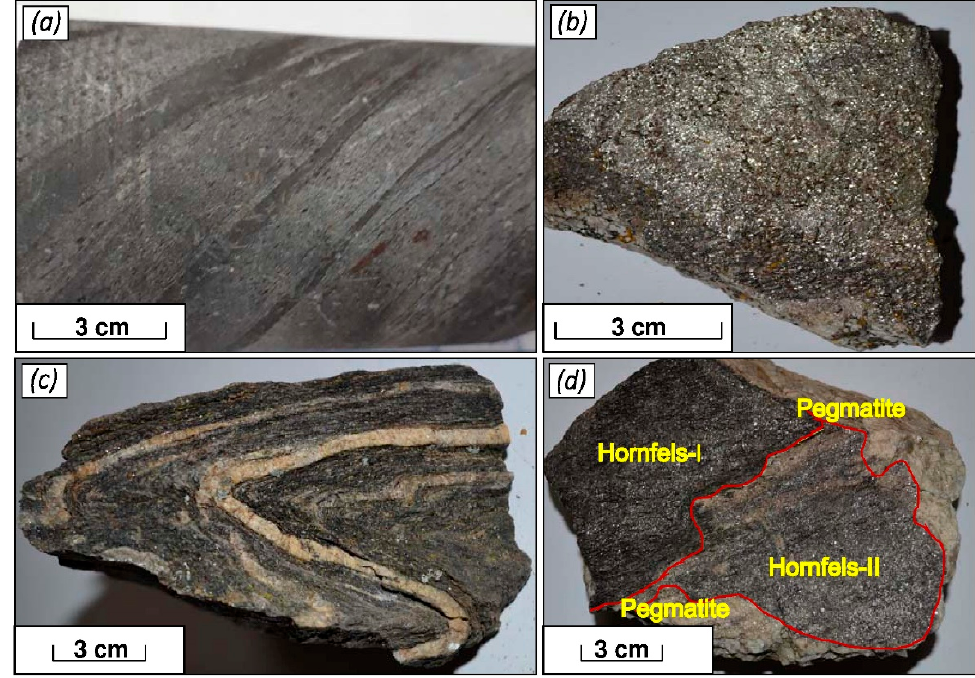
Figure 3. Takyr Fm. shales and hornfels from the Tochka area: black shale ( a ), muscovitized hornfels ( b ), folded hornfels with quartz veinlets ( c ), quartz–biotite–muscovite (I) and quartz–feldspar–muscovite (II) hornfels and pegmatite ( d ).